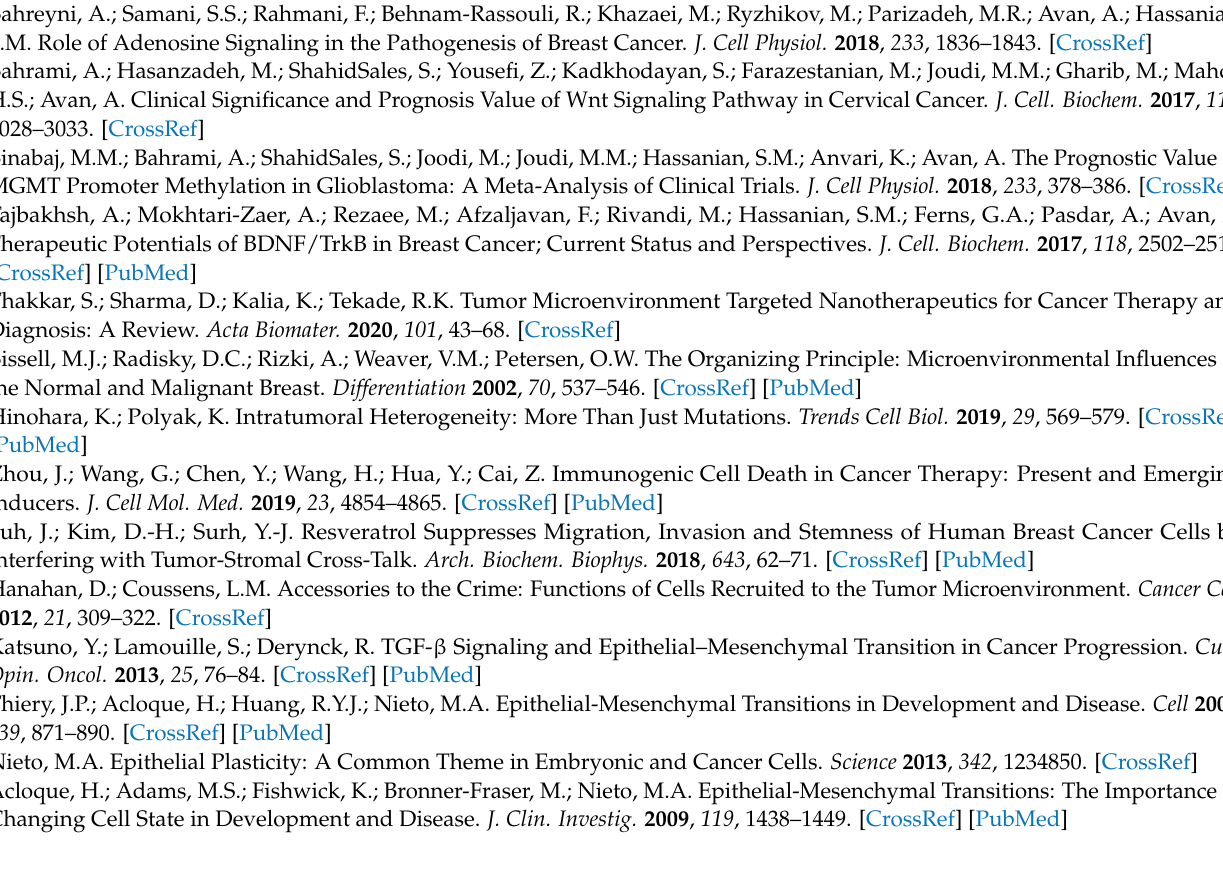
CD 3 OD) spectra of physodic acid showing only aliphatic regions, Figure S3: 1 H, 1 H-COSY spectrum (600 MHz, CD 3 OD) of physodic acid showing only aliphatic region, Figure S4: 1 H, 13 C-HSQC spectra (CD 3 OD) of physodic acid, Figure S5: 1 H, 13 C-HMBC spectra (CD 3 OD) of physodic acid, Table S1: 1 H (600 MHz, CD 13 C (600 MHz, CD δ , ppm) of physodic 3 OD) and 3 OD) NMR chemical shift (